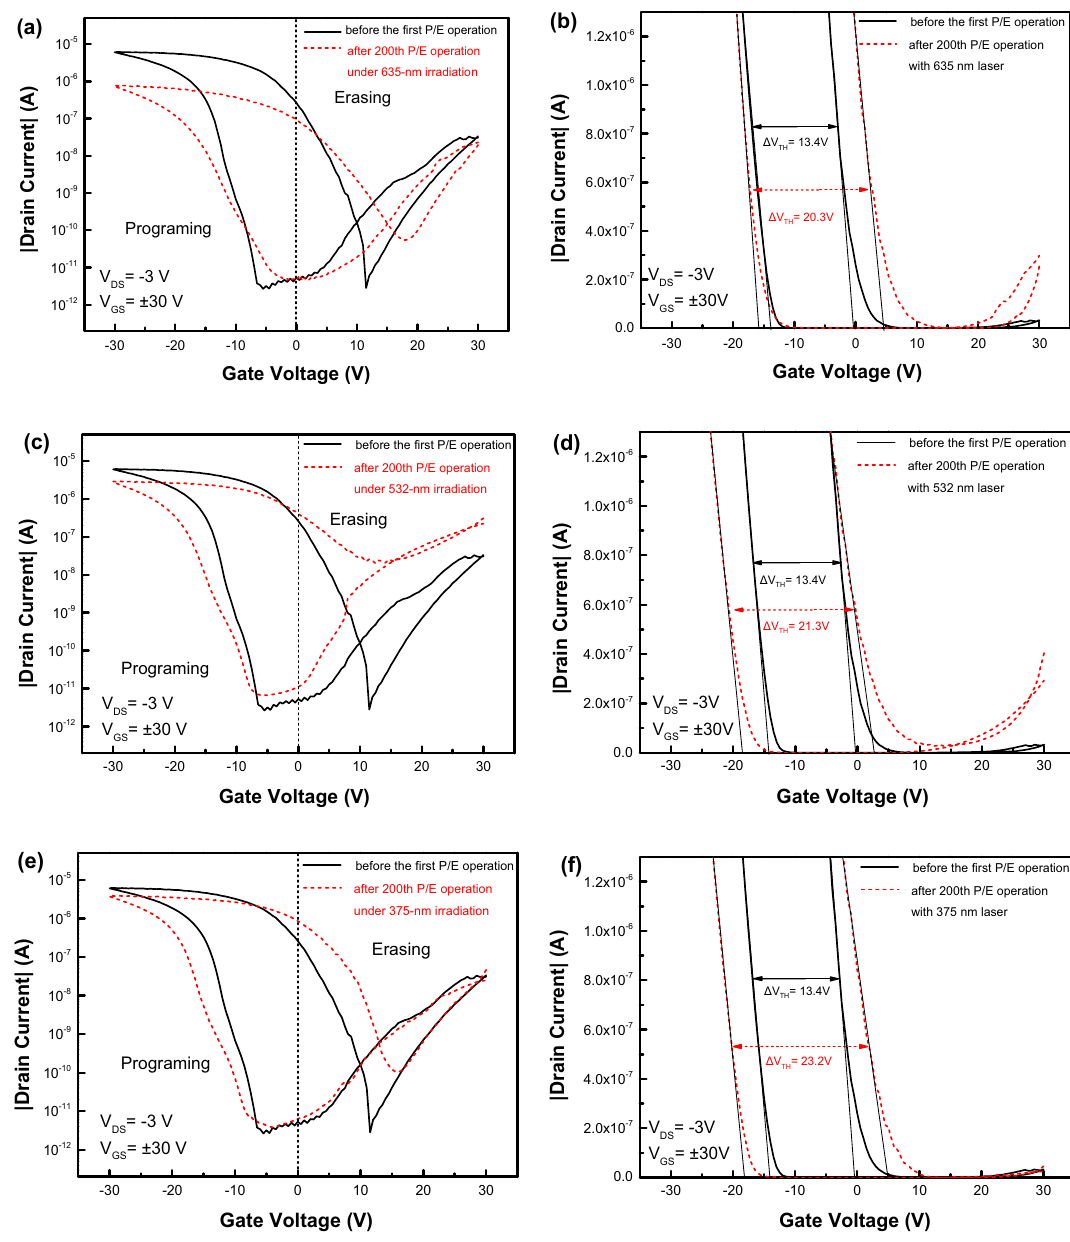
Figure 7. The transfer characteristics of pentacene OFET before and after the first run of 200-P/E-operation- cycles under photon-irradiation with a wavelength of 635 nm ( a ) in the logarithm form and ( b ) in the linear form, under photon-irradiation with a wavelength of 532 nm ( c ) in the logarithm form and ( d ) in the linear form, under photon-irradiation with a wavelength of 375 nm ( e ) in the logarithm form ( f ) in the linear